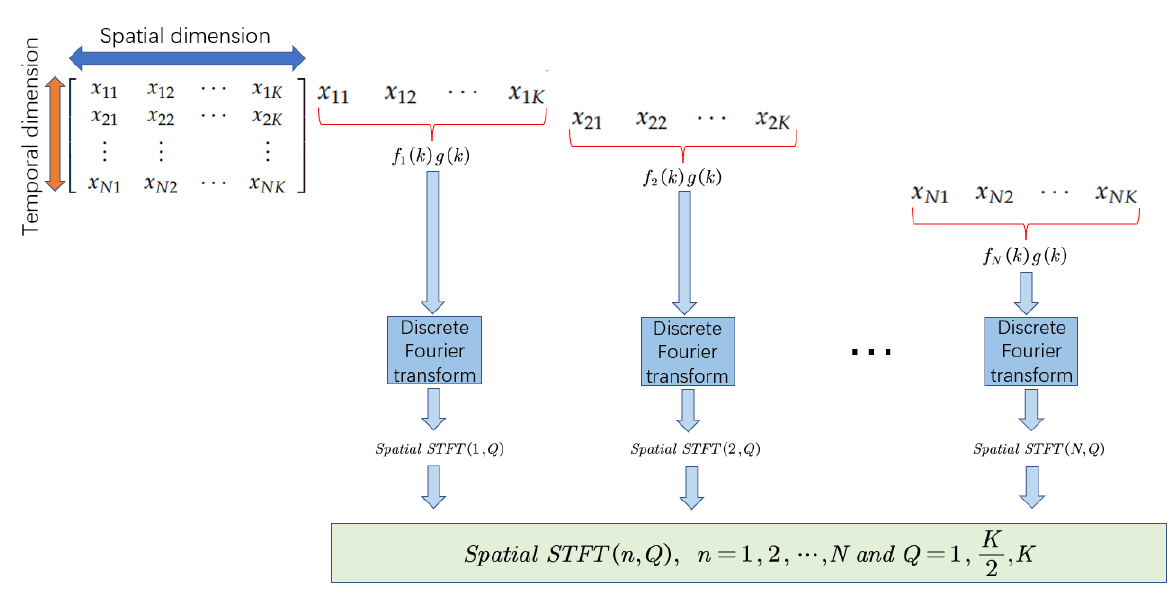
Figure 2. The calculation process of spatial